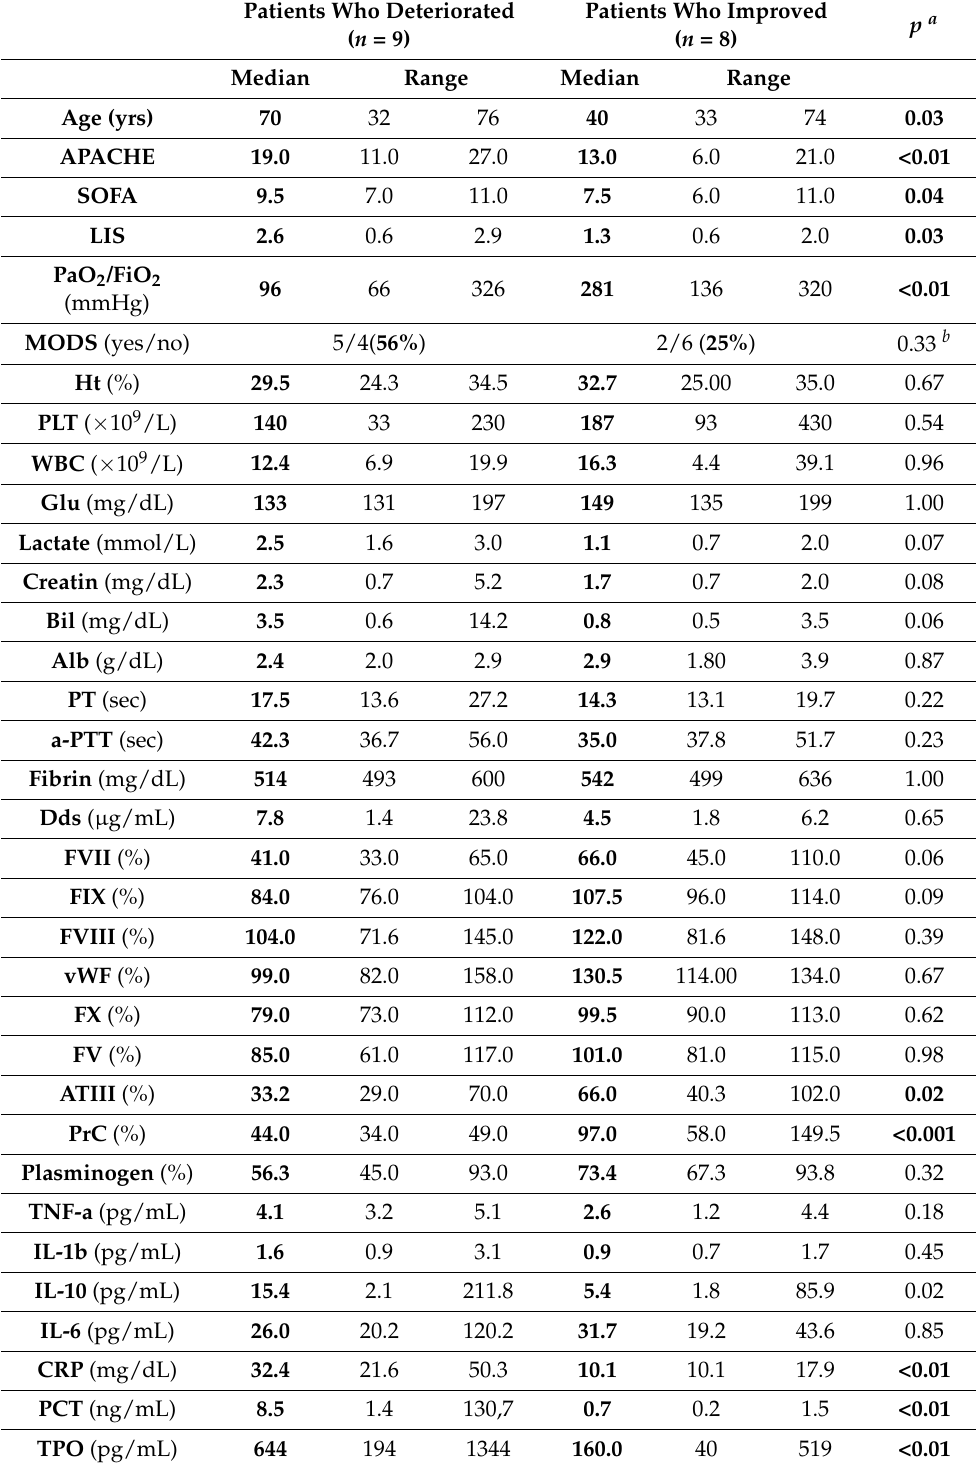
Table 6. Diagnosis of Severe Sepsis on ICU